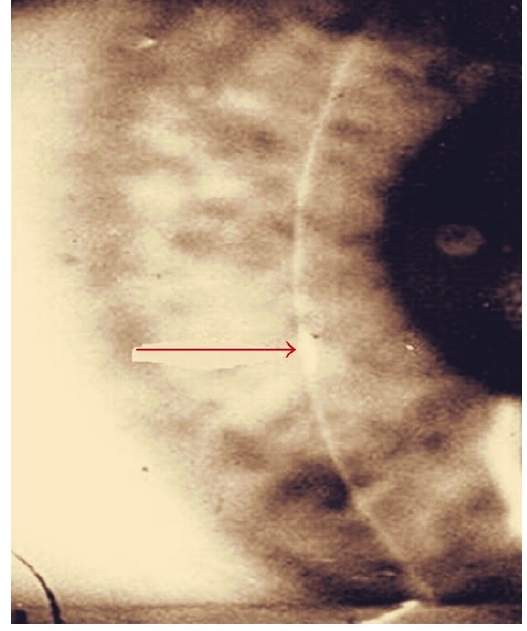
Figure 1. Slit-lamp examination of Cogan Syndrome . Interstitial Keratitis on slit lamp exam in a patient with Cogan Syndrome. [204]